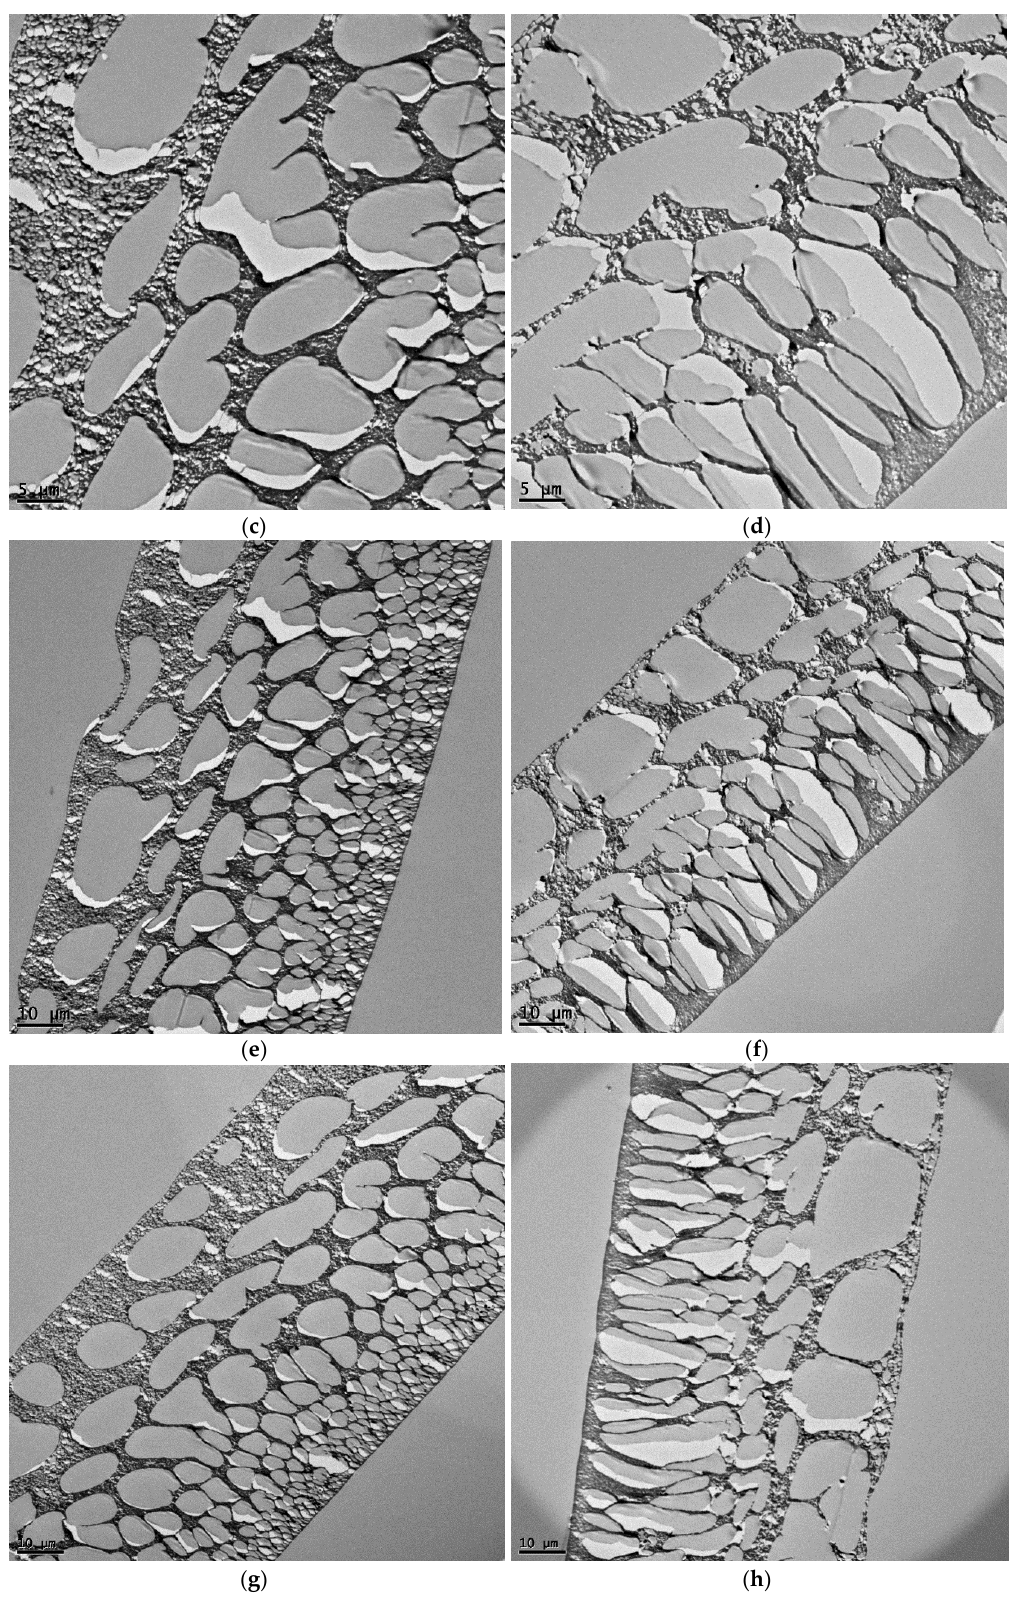
Figure 5. TEM images for the polysulfone support layer ( a , c , e , g ) 0% CNCs; ( b , d , f , h ) 6% CNCs.